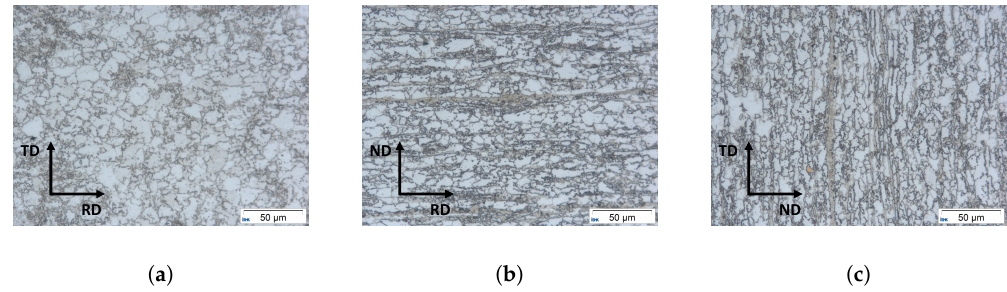
Figure 5. Three different crosssections of the materials microstructures show that it can be assumed that ellipsoids with a = b and a (cid:54) = c describes the microstructure better than regular spheres. The three crosssections show metallographic pictures of the Microstructure in the TD x RD-Plane ( a ), the ND × RD-Plane ( b ) and the ND × TD-Plane in ( c ).